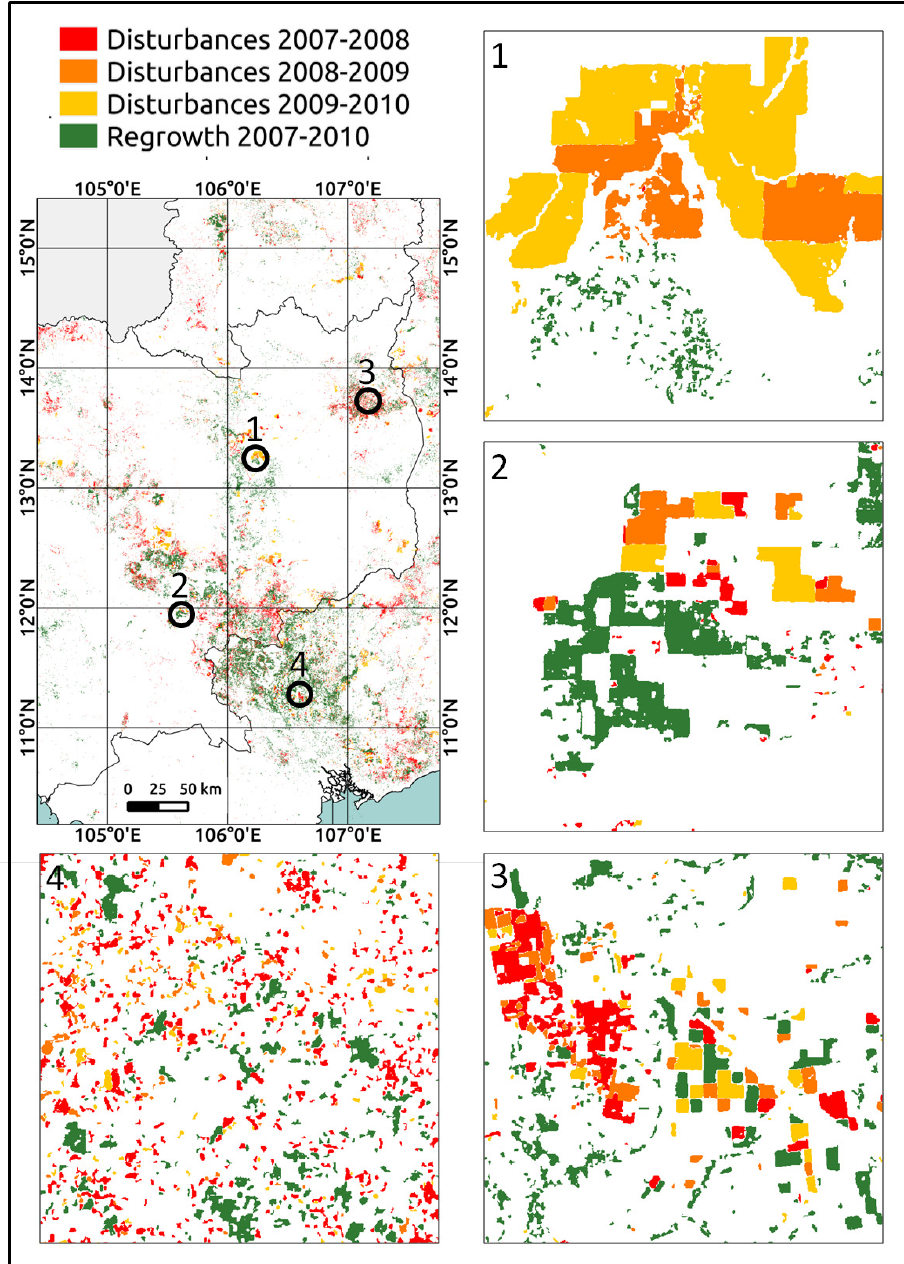
Figure 8. Forest disturbances and regrowth maps between 2007 and 2010 at 25-m resolution over 12 × 12 km areas in Cambodia and Vietnam, highlighting the various sizes and distributions of disturbed and regrowth